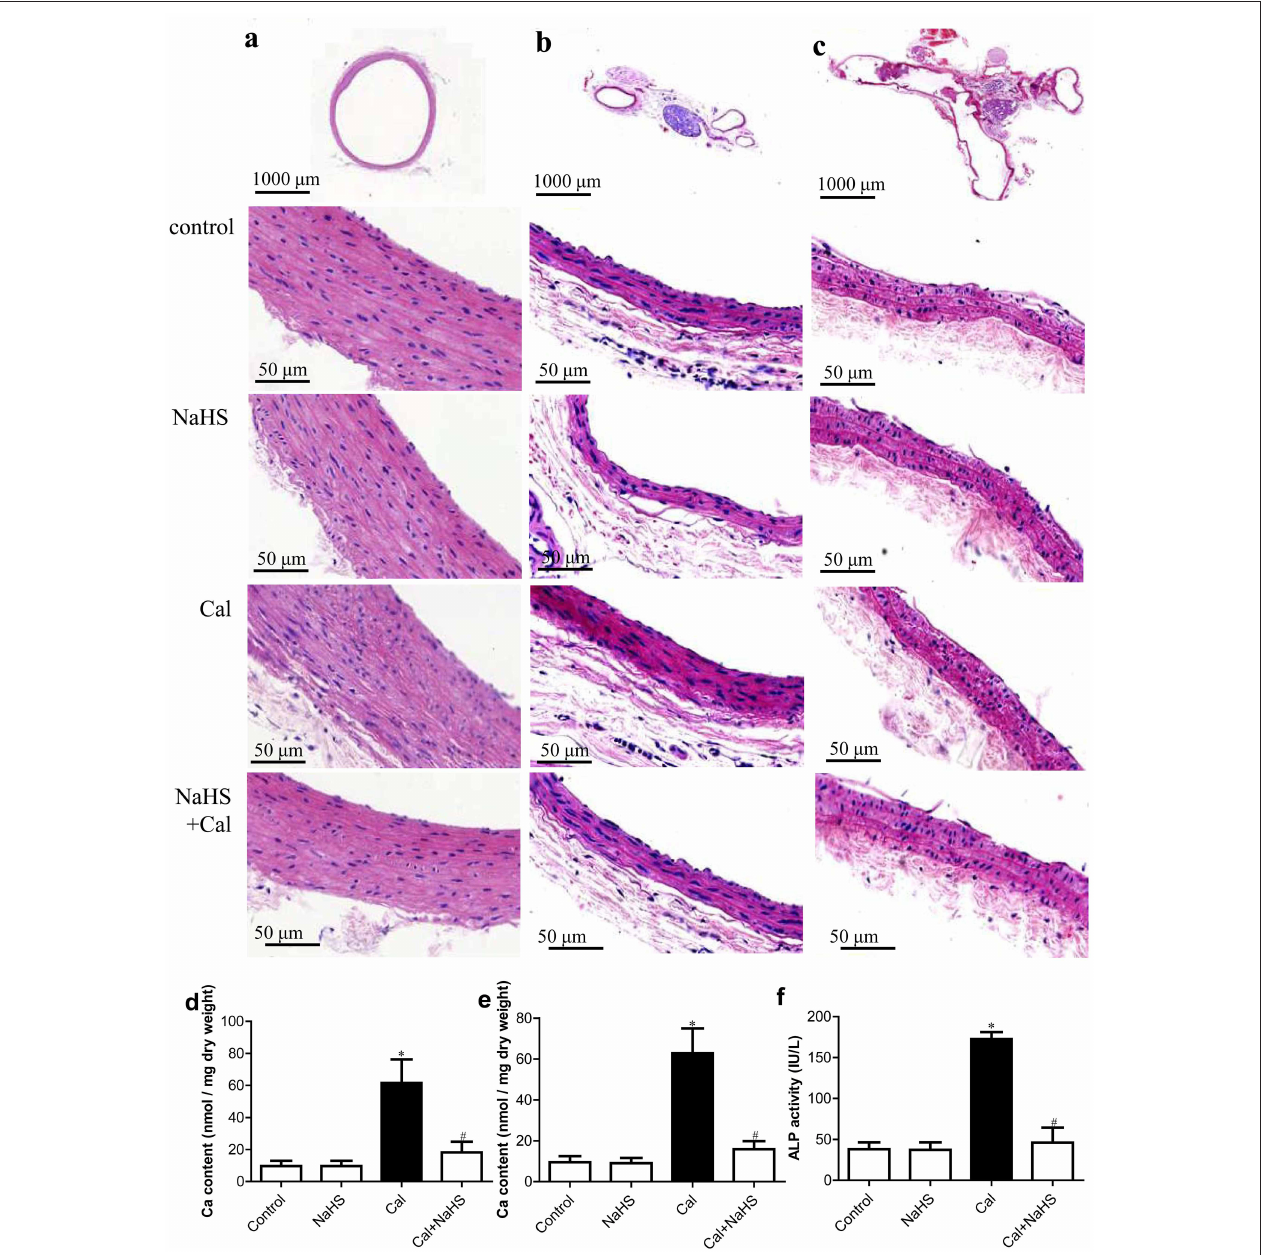
FIGURE 1 | H 2 S ameliorates vascular calcification (VC) detected by morphology of vascular vessels ( a , aorta; b , transverse section of carotid artery; c , longitudinal section of carotid artery), calcium content in aorta (d) , and carotid artery (e) , and plasma alkaline phosphatase (ALP) activity (f) . Data are mean ± SD. * P < 0.05 vs. control; # P < 0.05 vs. calcification (Cal) ( n = 8 each group).